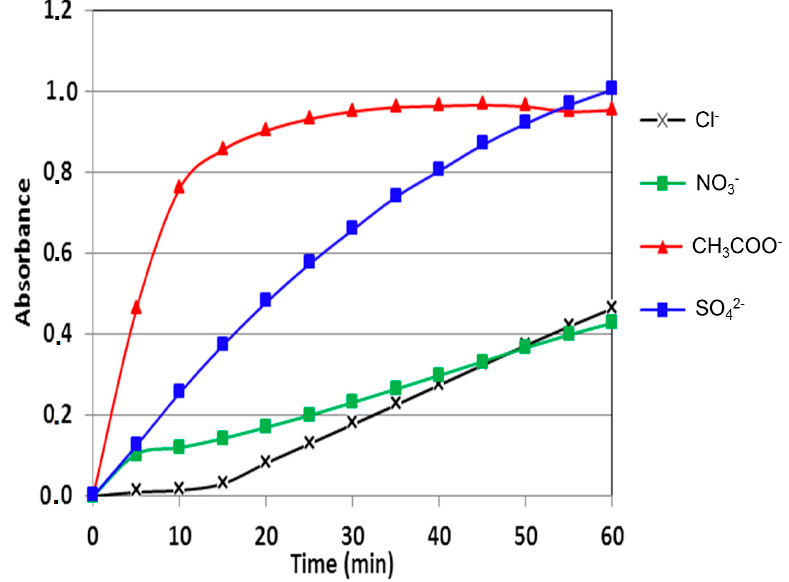
Figure 6. Catechol oxidation in the presence of copper complexes formed with L6 .